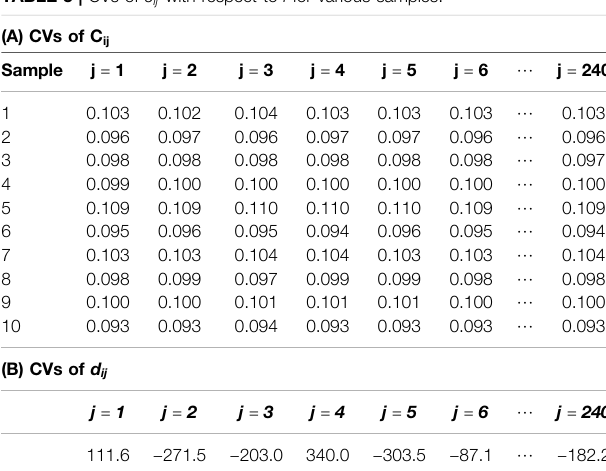
TABLE 3 | CVs of c ij with respect to i for various